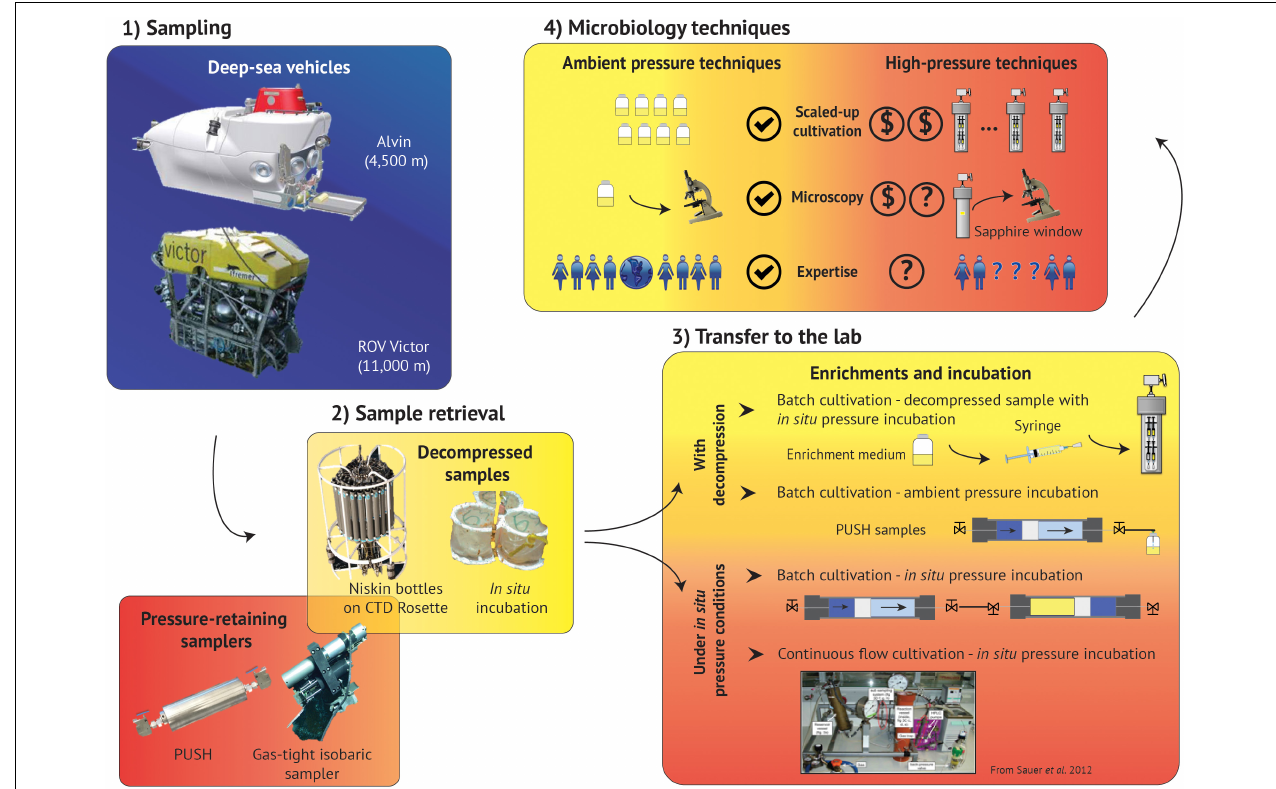
FIGURE 2 | Summary schematic of the deep-sea exploration workflow, from sampling to laboratory experiments. Access to deep marine environments is enabled with submersibles (1 – Sampling), along with the various devices that support 2 – Sample retrieval. 3 – Transfer to the lab and subsequent cultivation techniques often include batch cultivation, but can also accommodate continuous flow methods, though many of these techniques require sample decompression. 4 – Microbiology techniques are much more robust for ambient pressure conditions, and high-pressure analogs of these methods require technology development, high-pressure expertise, and can also increase the costs, and thus decrease the accessibility, of many of these protocols. (Box 1: Alvin picture is reprinted from Woods Hole Oceanographic Institution website (link: https://www.whoi.edu/oceanus/feature/building-the-next-generation-alvin-submersible/) 2019 Copyright WHOI, ROV Victor picture is reprinted from Ifremer website (link: https://wwz.ifremer.fr/grands_fonds/Les-moyens/Les-engins/Les-robots/Robots-Ifremer/Le-Victor-6000) 2019 Copyright IFREMER; Box 2: PUSH is a personal picture, Isobaric sampler picture is reprinted from Woods Hole Oceanographic Institution website